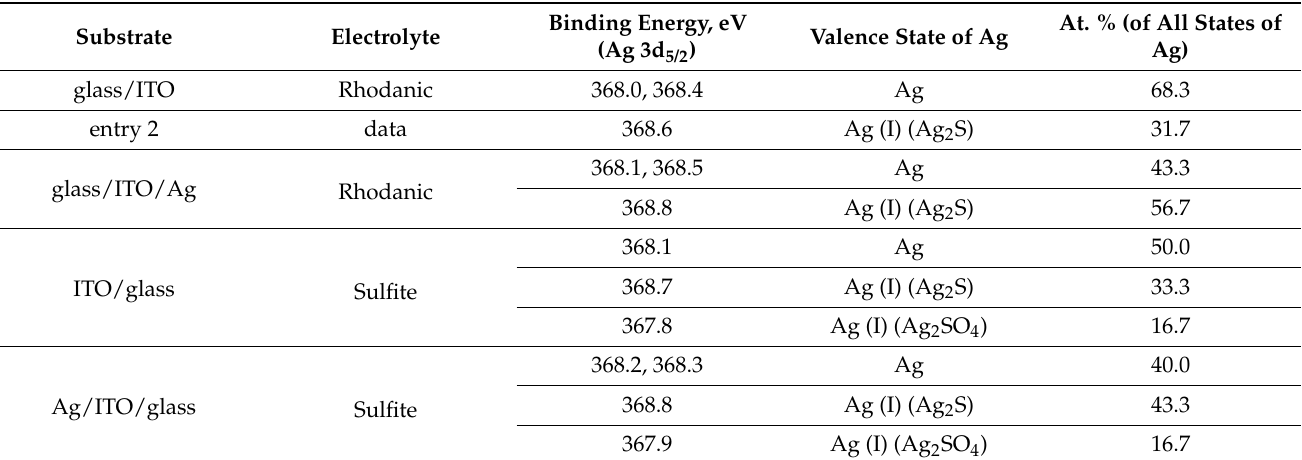
Table 2. XPS data valence states of the Ag for the films deposited using rhodanic and sulfite electrolytes.